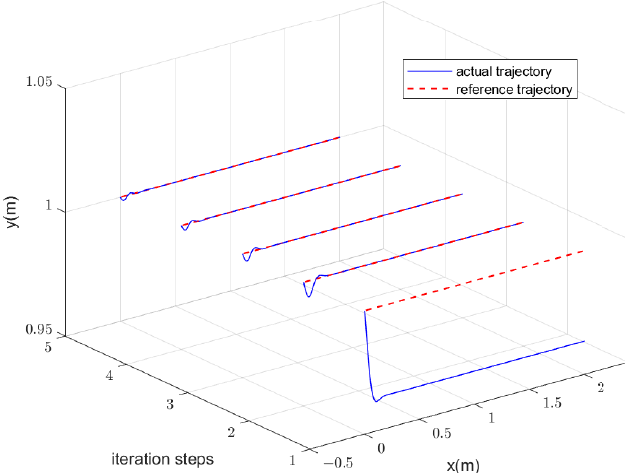
Figure 10. Iterative tracking result graph under model mismatch.